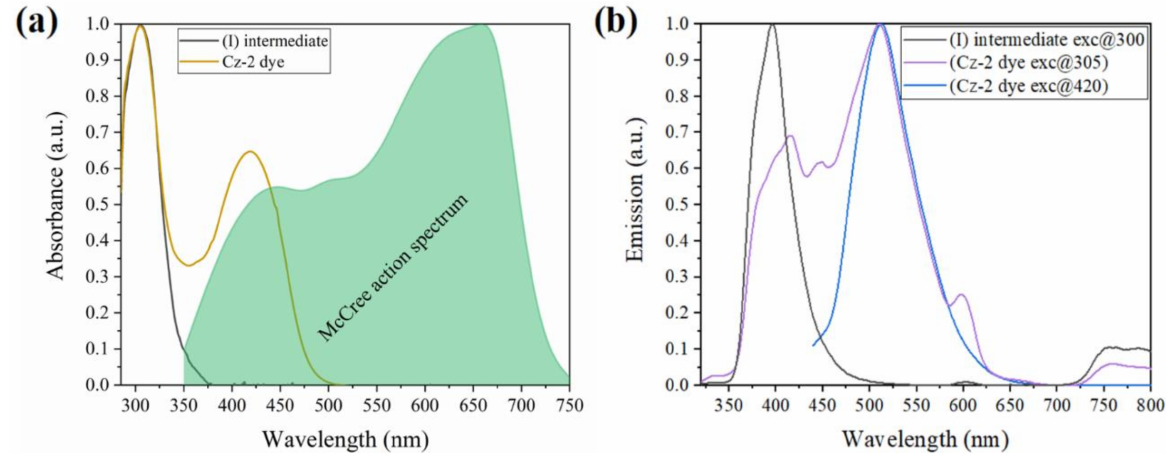
Figure 3. Optical characteristics of the (I) intermediate and Cz-2 dye in tetrahydrofuran (THF) solution: ( a ) UV-Vis spectra and ( b ) photoluminescence (PL) spectra after excitation at the respective absorption maxima.